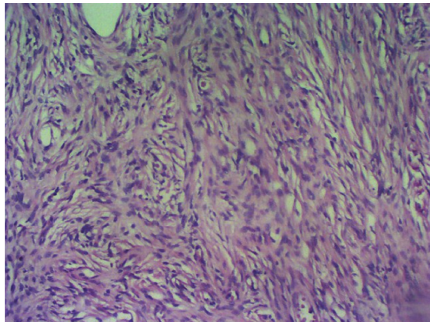
Figure 2: Hematoxylin and eosin stained section shows spindle- shaped cells.